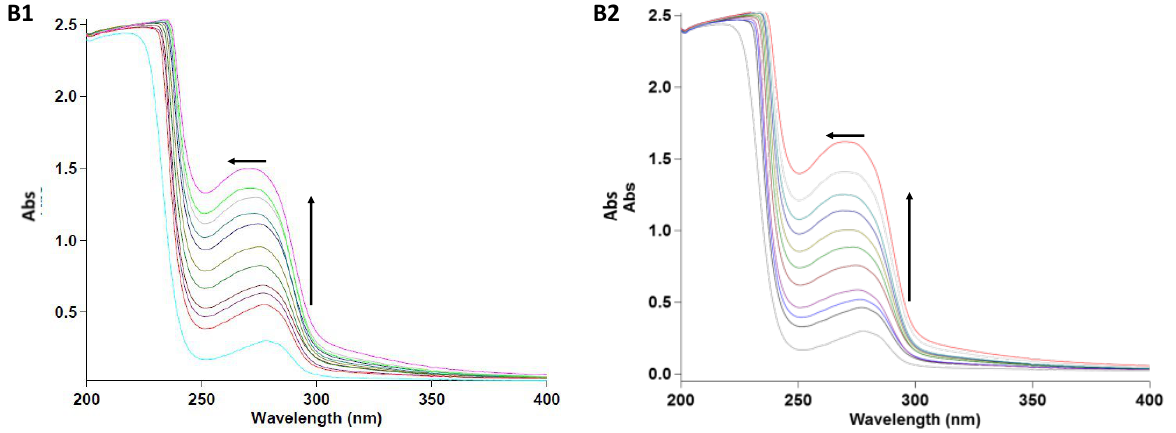
Figure 6. Absorption spectra of BSA (1 µM) upon gradual addition of B1 and B2 (0–10 µM). Upper arrows show the blue shift in wavelength with the gradual addition of B1 and B2 . Upside arrows indicate the change in the absorption in the increased B1 and B2 concentrations.